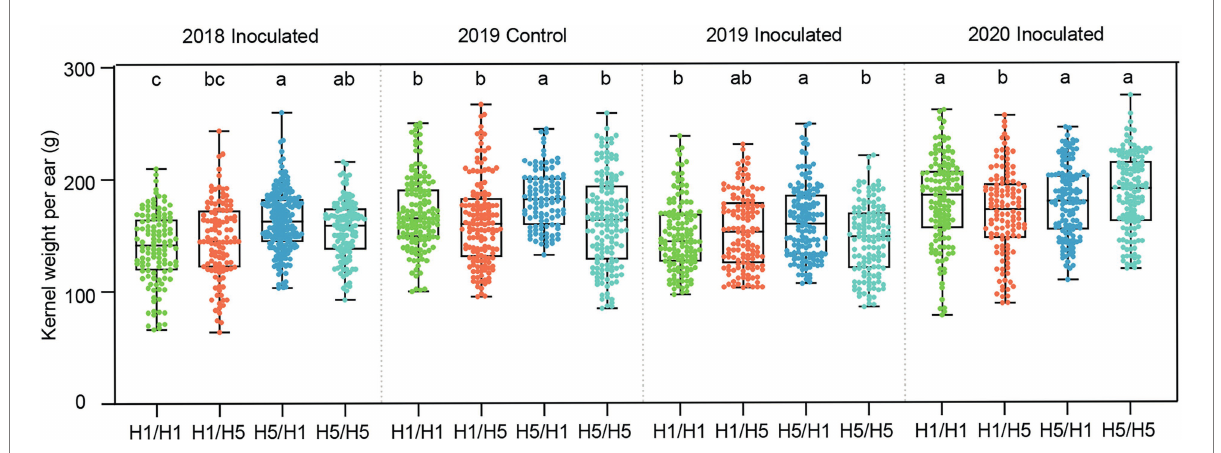
FIGURE 4 The kernel weight per ear of hybrids in Beijing under control and biotic stress. H1/H1, H1/H5, H5/H1, and H5/H5 are genotypes of four hybrids represent 83B28 H1 × A5302 H1 , 83B28 H1 × A5302 H5 , 83B28 H5 × A5302 H1 , and 83B28 H5 × A5302 H5 , respectively. Boxes show mean and quartile, whiskers represent max to min. Different letters indicate significant differences among hybrids ( p < 0.05, one-way ANOVA, Tamhane’s test and Duncan’s